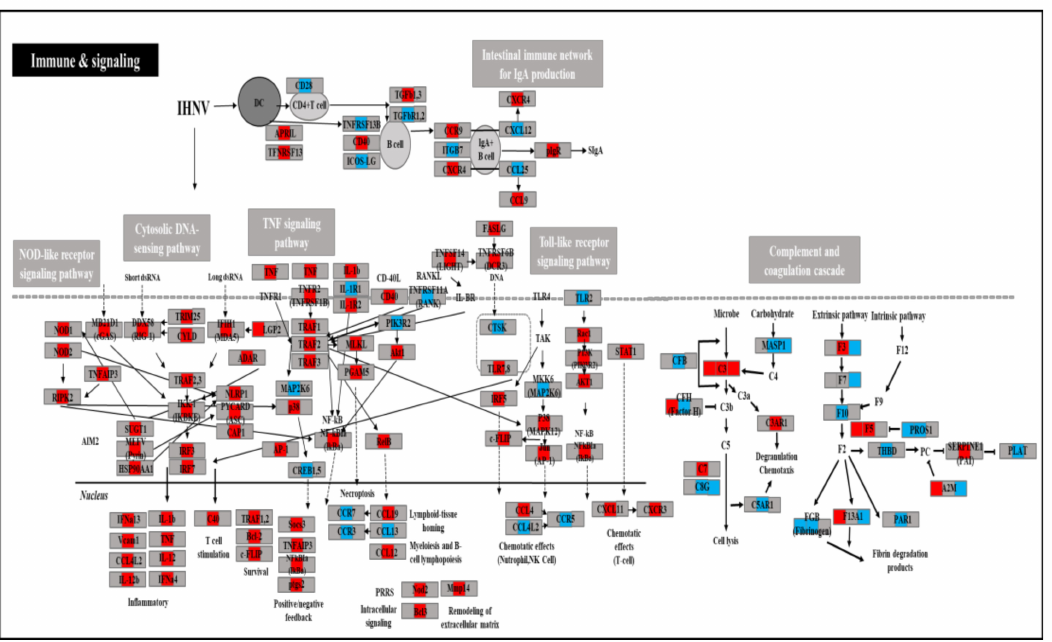
Figure 4. Presentation of putative immune pathways on days 1, 3, and 5 in the IHNV-infected